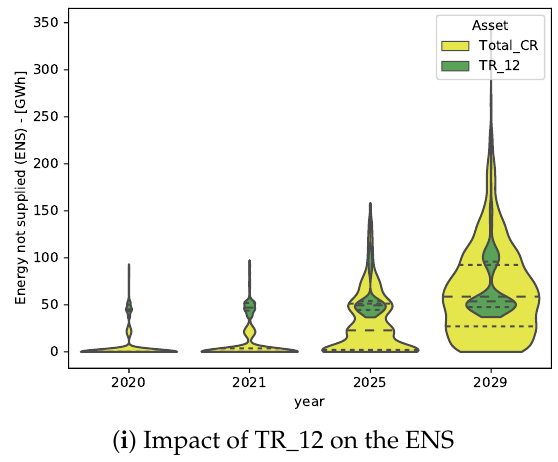
Figure 10. Impact of asset fleet failures on the cumulative expected ENS.